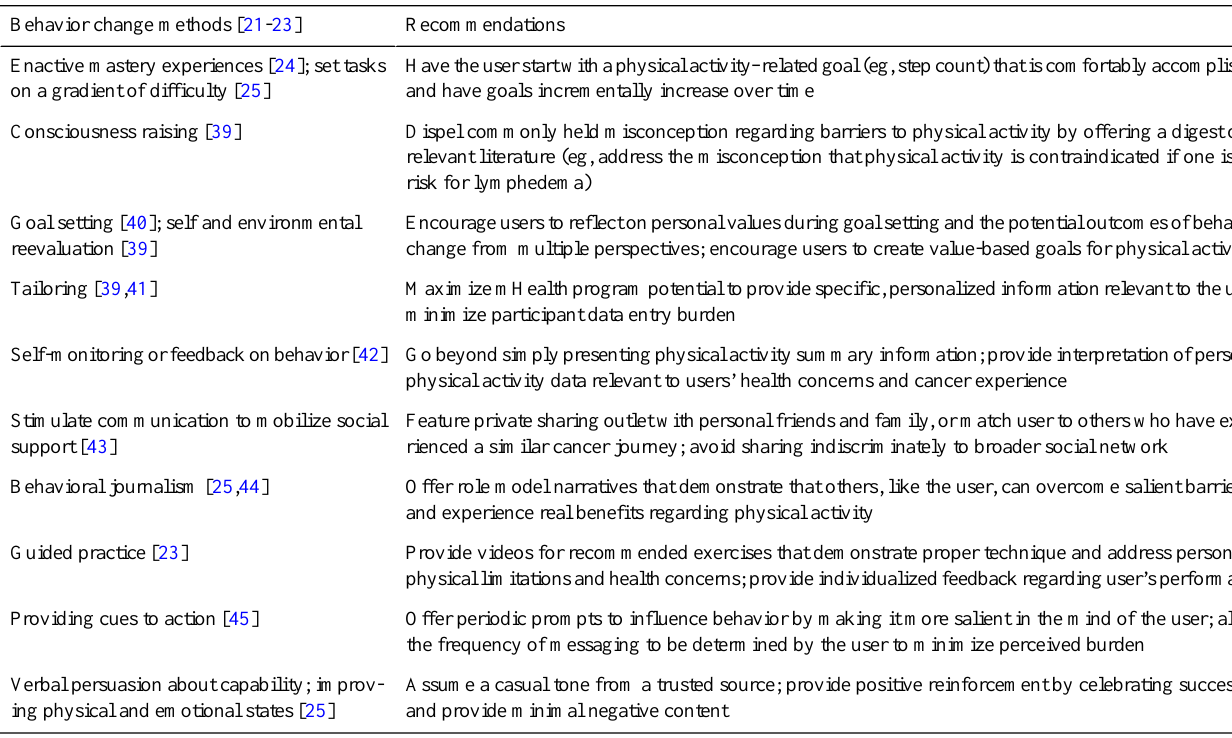
Table 6. Behavior change recommendations that may improve acceptability. RecommendationsBehavior change methods